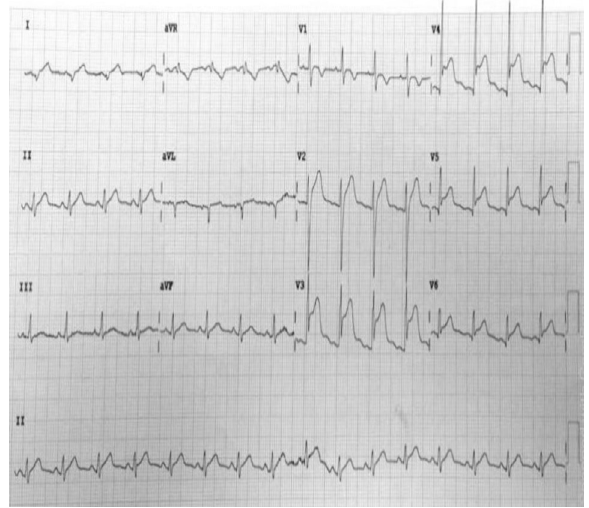
Figure 1. Initial ECG shows ST elevations from leads (Figure 2). His cardiac biomarkers were significantly raised with serum CK-MB of 76 U/L and high sensitivity troponin T of 1.585 μg/L. Total white cell counts were also raised at 18.3 × 10 9 /L. His chest radiograph was unremarkable.